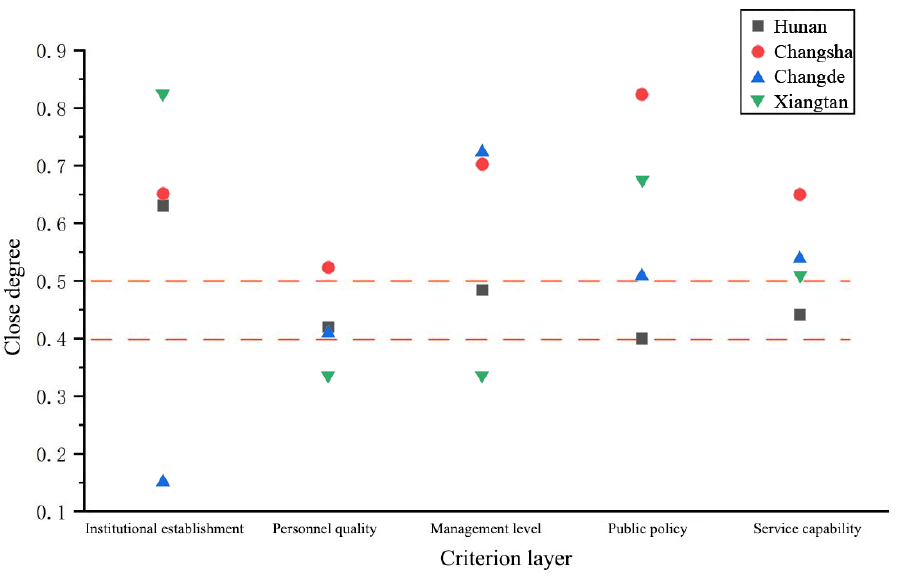
Figure 4. The first level of close degree of criterion layer of grassroots water service in Hunan Prov- ince.